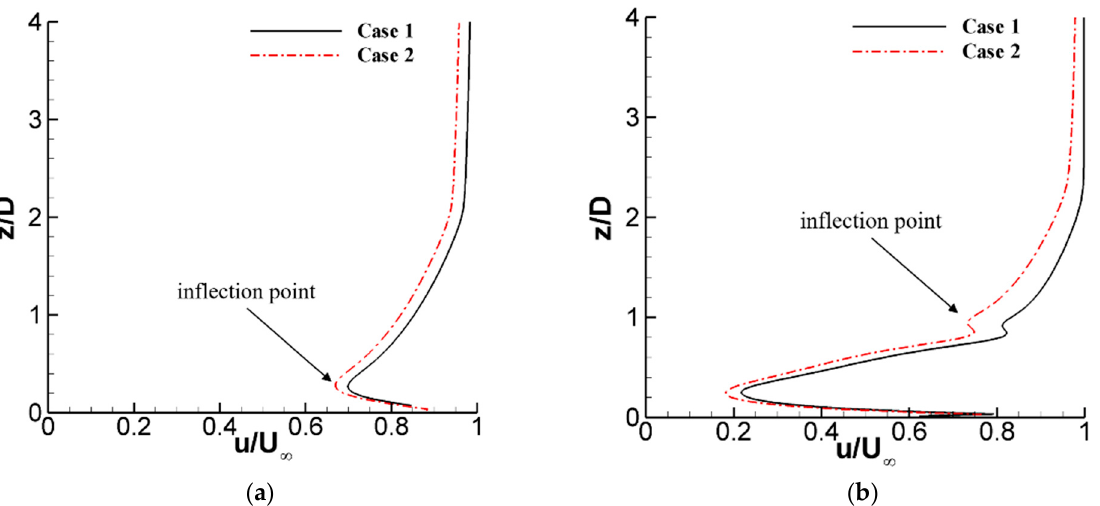
Figure 5. Comparison of the x -velocity profiles at ( a ) x / D = − 2.0 and ( b ) x / D = 2.0 on mid-span plane of Case 1 and Case 2.